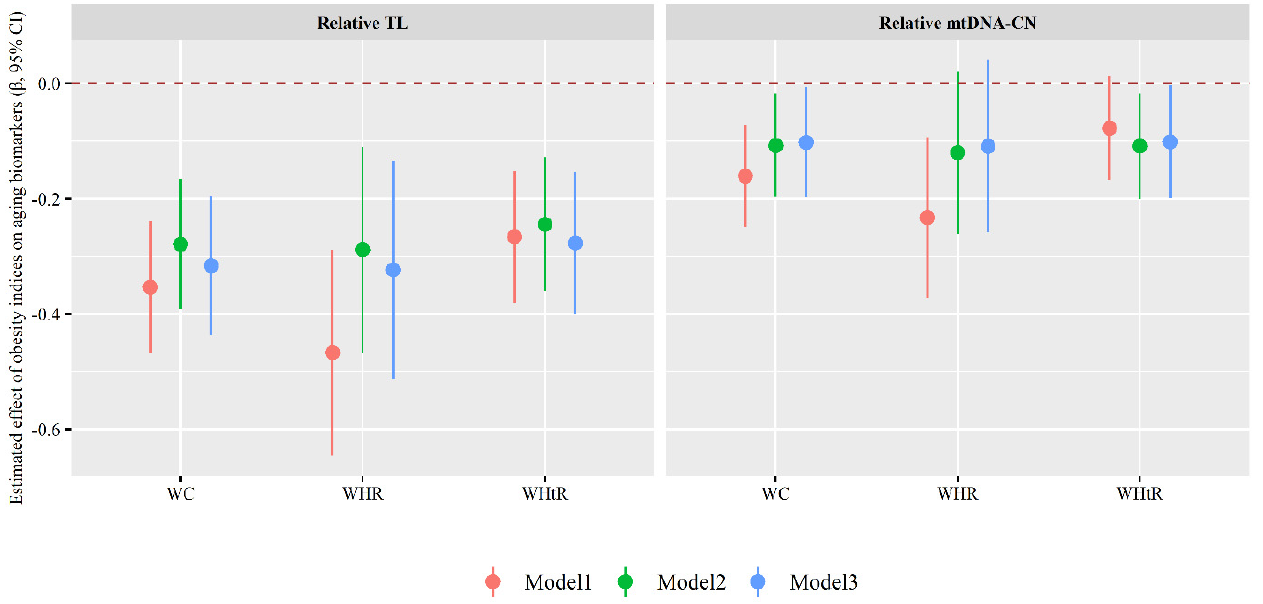
Figure 3. Associations of obesity indices with aging biomarkers. Model 1 was the crude model; Model 2 was adjusted for individuals’ demographic characteristics (such as age, sex, personal average monthly income, marital status, and educational attainment) and lifestyle behavior (such as physical activity, drinking and smoking status, vegetable and fruit intake, and high fat diet); Model 3 was additionally adjusted for hypertension, type 2 diabetes mellitus, dyslipidemia, and family